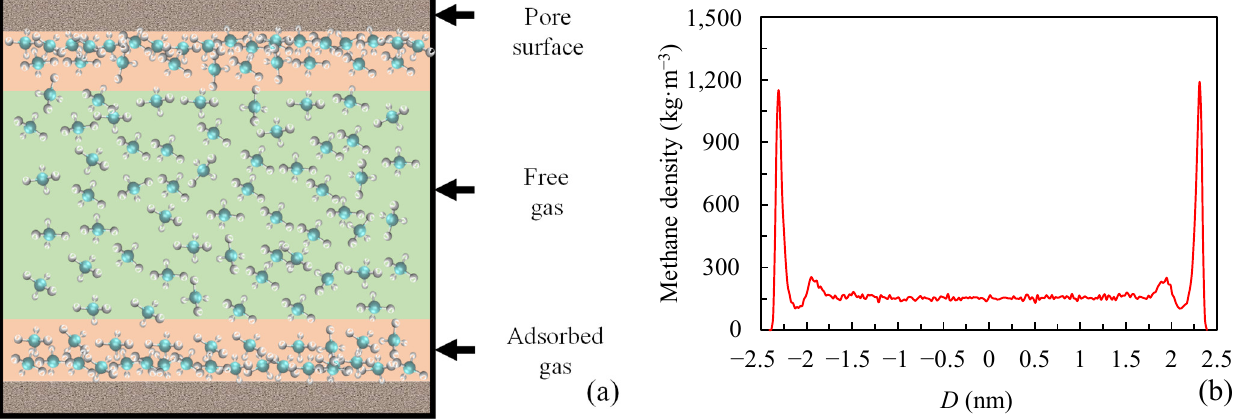
Figure 7. ( a ) Diagram of methane distribution in shale pores and ( b ) molecular dynamics simulation of methane density distribution curve in 5 nm graphite pore. Methane adheres to the adsorption sites on the pore surface to form adsorbed gas, which can be adsorbed by a single layer or multilayers. The high-density area at the pore wall is adsorbed methane, and the low-density area in the pore-free space is free methane. The amount of adsorbed gas depends on the surface area of the pore and the gas pressure. In the free space in the middle of the pores, methane occurs in the form of free gas, and the amount of free gas depends on the pore volume and gas